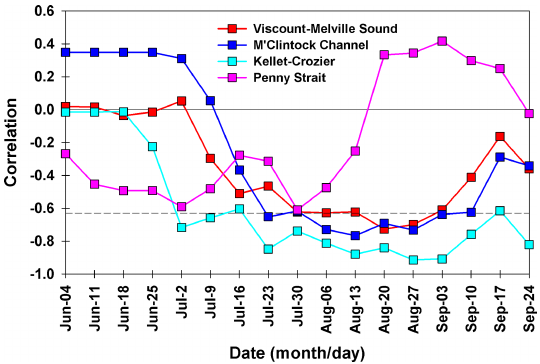
Figure 10. Time series of detrended correlations between RADARSAT-2 peak melt pond fraction ( f pk ) and weekly sea ice area for selected regions in the Canadian Arctic Archipelago from June to September. The dashed black line is statistical significance at the 95% confidence level.